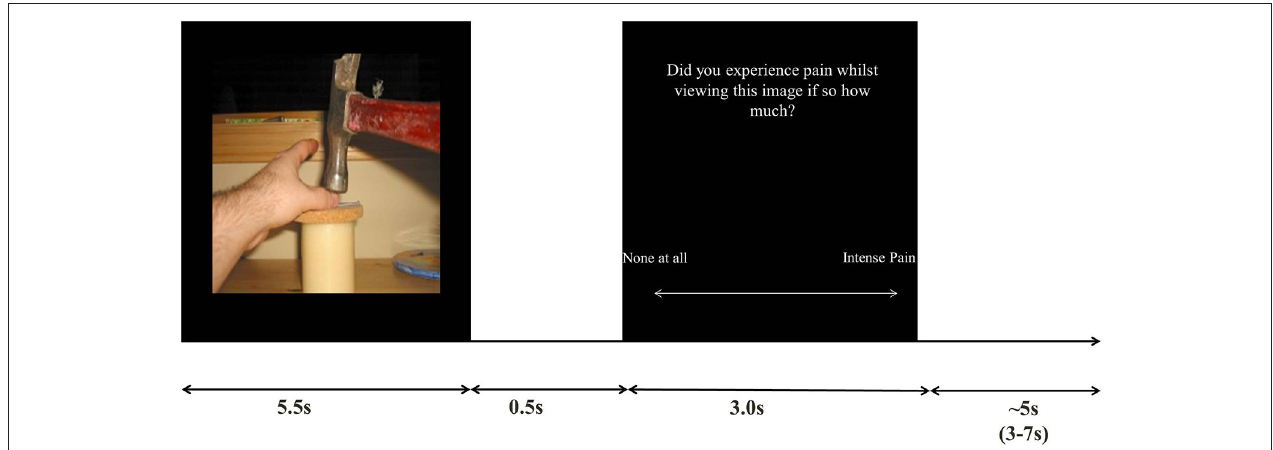
FIGURE 1 | Stimulus example and trial